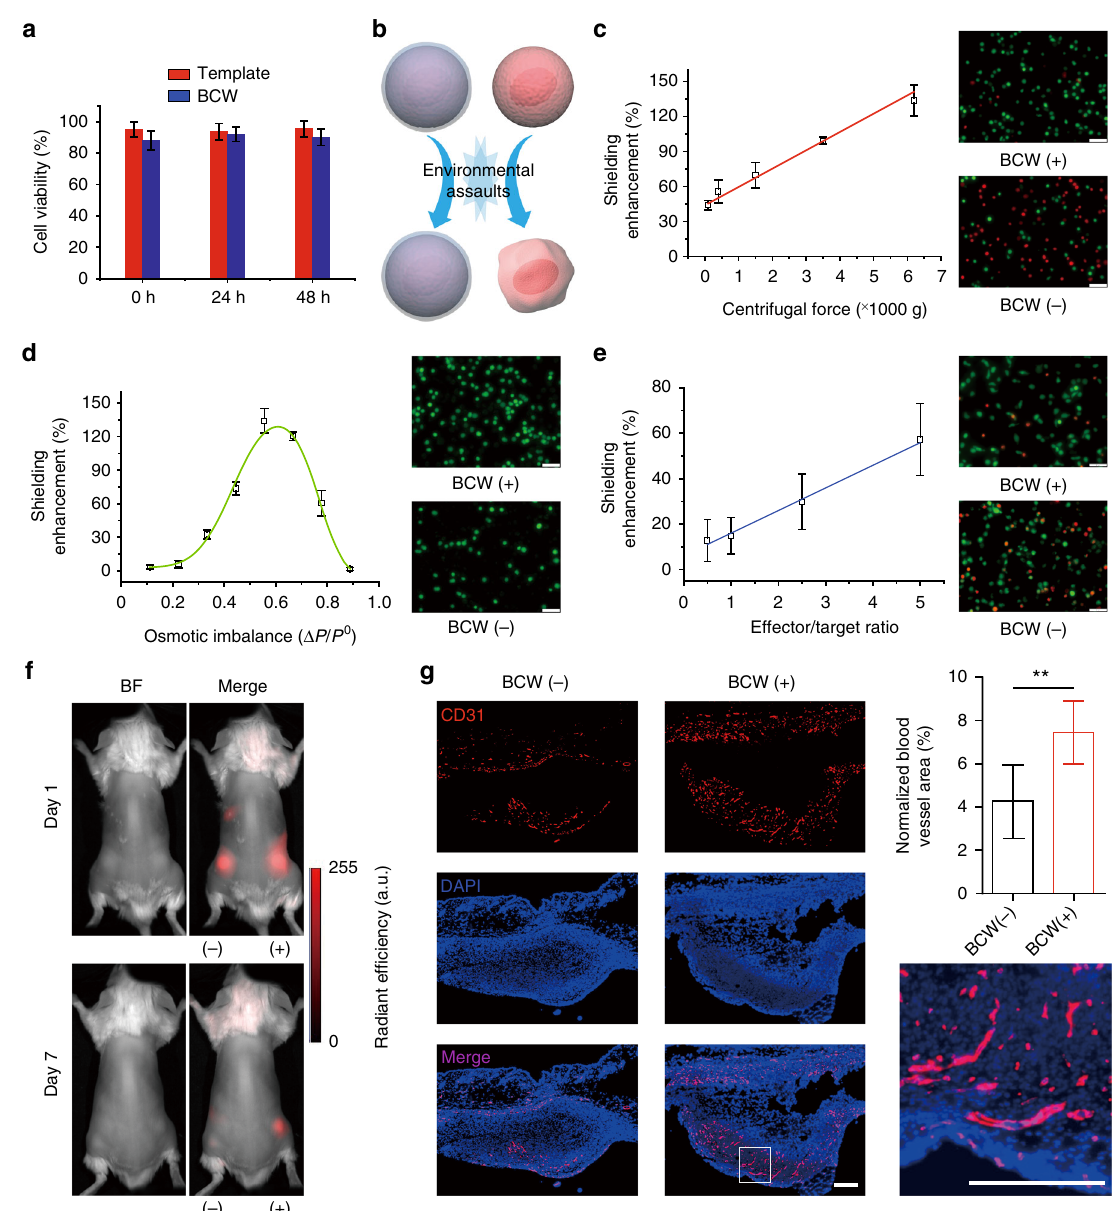
Fig. 5 Evaluation of shielding enhancement. a Examination of cell viability at different time points. The viability of native cells was used as 100%. 0 h: analysis of the cells right after the synthesis of the template or BCW. b Schematic comparison of the cells covered with (bottom) or without (top) BCW when exposed to environmental assaults. c Shielding enhancement-centrifugal force relationship. After the assault, the cells were cultured and examined with the LIVE/DEAD staining. Green: live; red: dead. Representative images were taken after the cells were exposed to the centrifugal force of 6200× g . d Shielding enhancement-osmotic imbalance relationship. The cells were stained with Calcein-AM (green) for imaging before exposed to the conditions of osmotic imbalance. Representative images were taken after the cells were incubated in the solution of 0.4% NaCl. CCRF-CEM was used for Fig. 5a – d. e Shielding enhancement-immune attack relationship. K562 and NK-92MI were used as target and effector cells, respectively. Representative images were taken at the 2.5:1 effector/target ratio. Green: CFSE. Red: dead cells. Scale bars: 50 μ m. Data are presented as mean ± standard deviation as indicated by error bars ( n = 3). f In vivo imaging of human bone marrow MSCs subcutaneously transplanted into the mice. MSCs expressed red fl uorescence protein (RFP). BF, bright fi eld. ( − ): naked cells (without BCW); ( + ): BCW-covered cells. Color-coding of fl uorescence intensity in arbitrary units (a.u.) is equally scaled for the images. g Staining of endothelial cells using a mouse-speci fi c anti-CD31 antibody. ** p < 0.01. The paired Student ’ s t -test was used to compare the two groups. Scale bars: 200 μ m. Data are presented as mean ± standard deviation as indicated by error bars ( n =